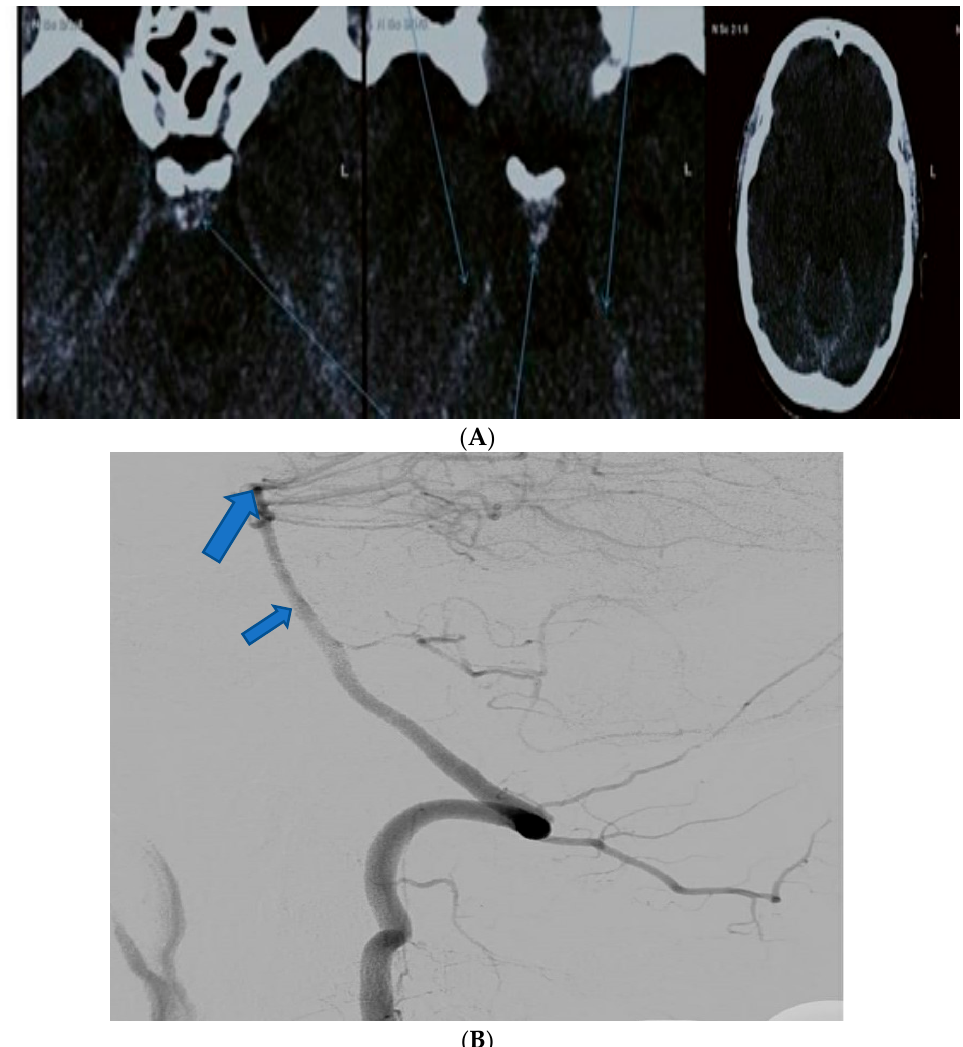
Figure 1. ( A ) The case of a 41-year-old male without any significant clinical history who presented in our clinical establishment complaining of diplopia. Axial native CT highlighting blood near the cerebellar tentorium and prepontine cistern (arrows). ( B ) The same case. Digital subtraction angiography showing no aneurysmal dilatation of the basilary artery (small arrow), cerebellar or proximal posterior cerebral artery (large arrow).